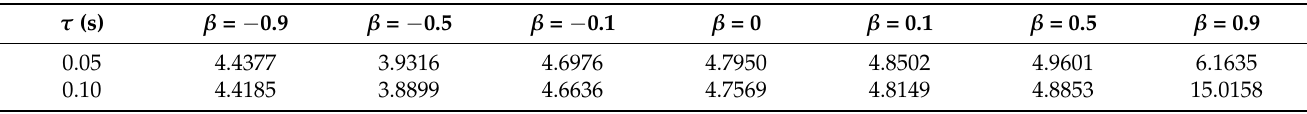
delays and different fractional orders in the proposed